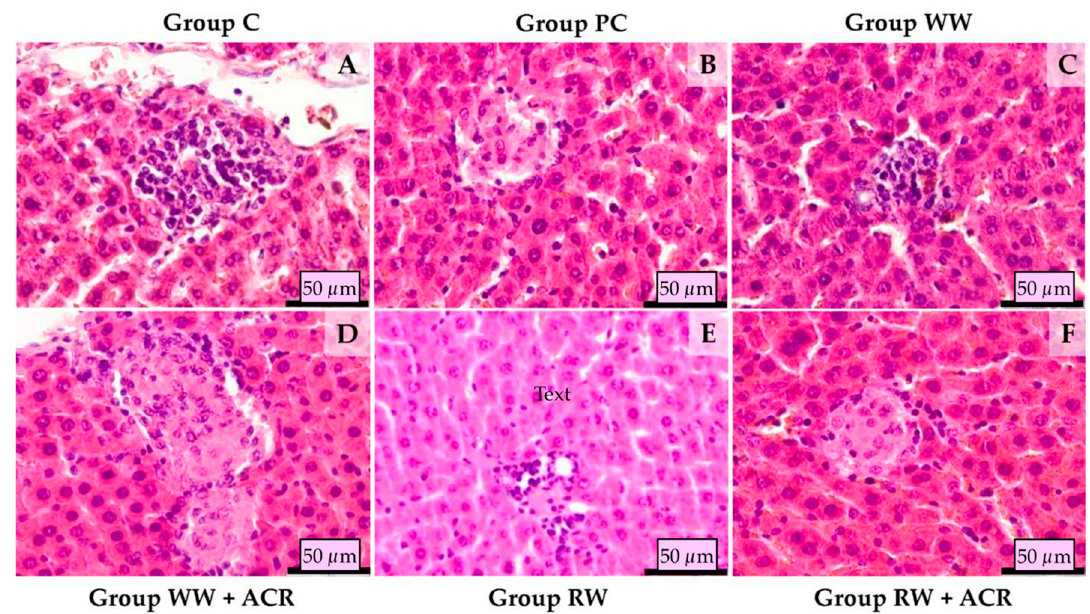
Figure 2. Hepatic histology in rats from different experimental groups (HE stain). Control group